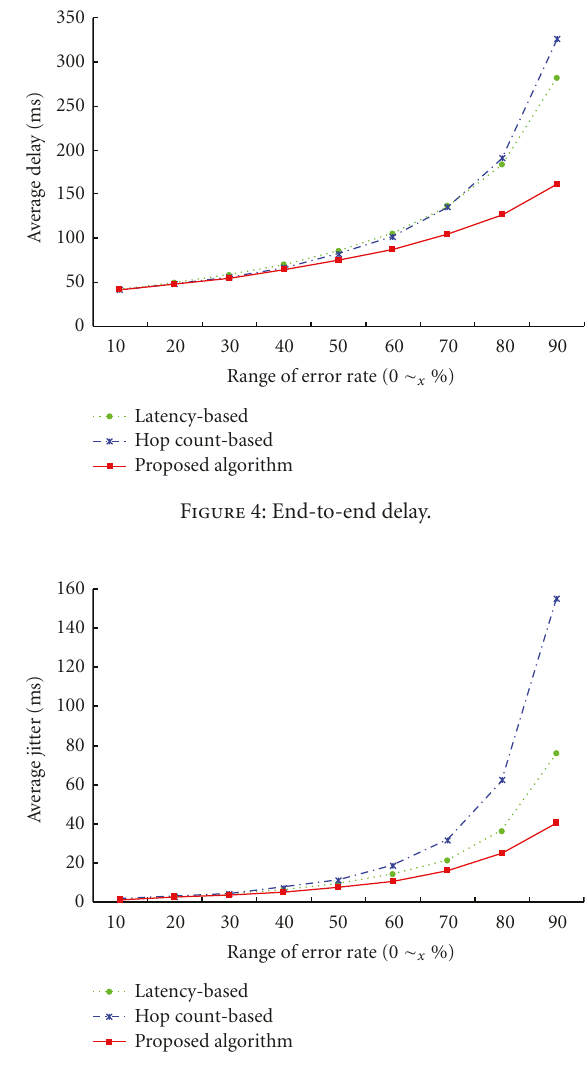
Figure 5: Average